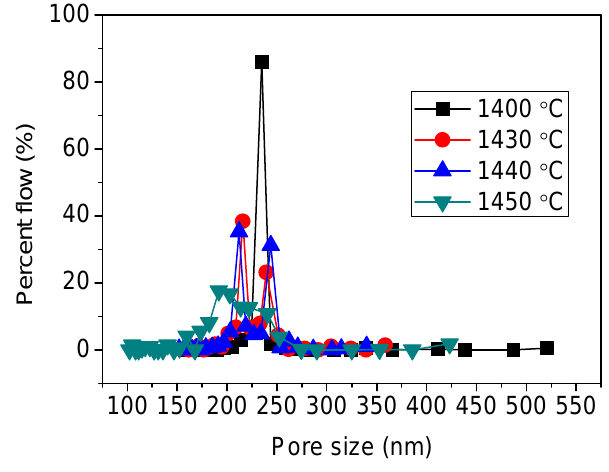
Figure 5. Gas ‐ liquid ‐ displacement pore size distributions of the Al 2 O 3 ‐ YSZ membranes sintered at Figure 5. Gas-liquid-displacement pore size distributions of the Al 2 O 3 -YSZ membranes sintered at different temperatures. different